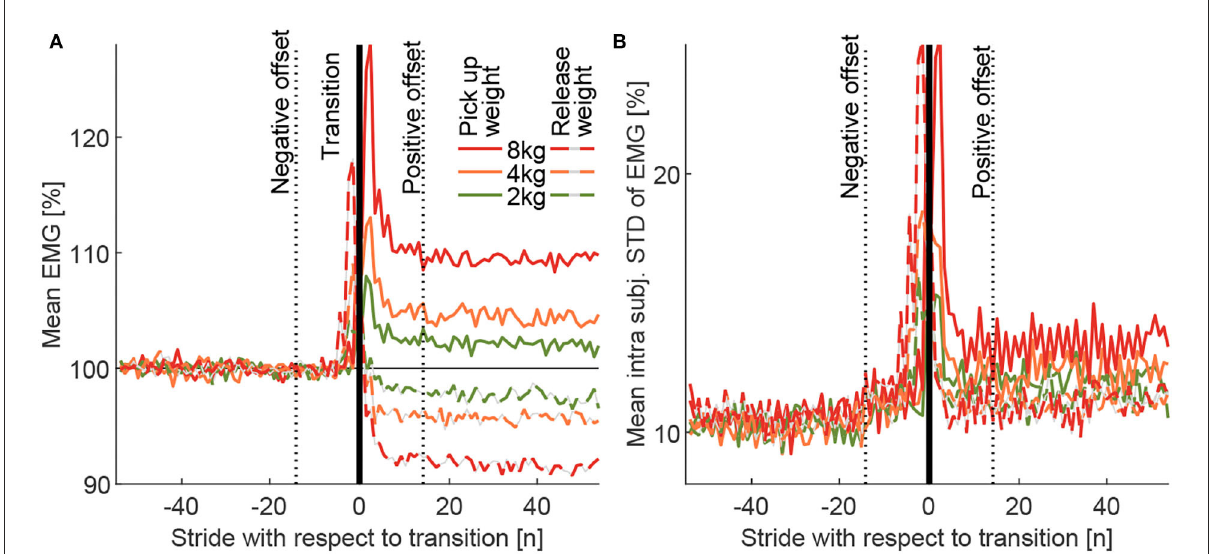
FIGURE6 (A) The Grand mean of the MAVs (MAV stride ) and (B) grand mean of the intra-subject standard deviation (MAV stridestd ) for the transitions from the loaded to the unloaded condition (dashed) and the unloaded to loaded condition (solid) for the total carried mass of 2, 4, and 8kg. The curves include data for all 5 muscles, both limbs (right, left), all 13 subjects, and all 10 transitions performed for each weight. The transition strides were defined by the movement of both weights. The follow-up condition is always presented relative to the previous condition, which is defined to have a mean of 100% (not including offset and transition strides). The positive (14 strides) and negative offsets (14 strides) were defined by visual observation of these